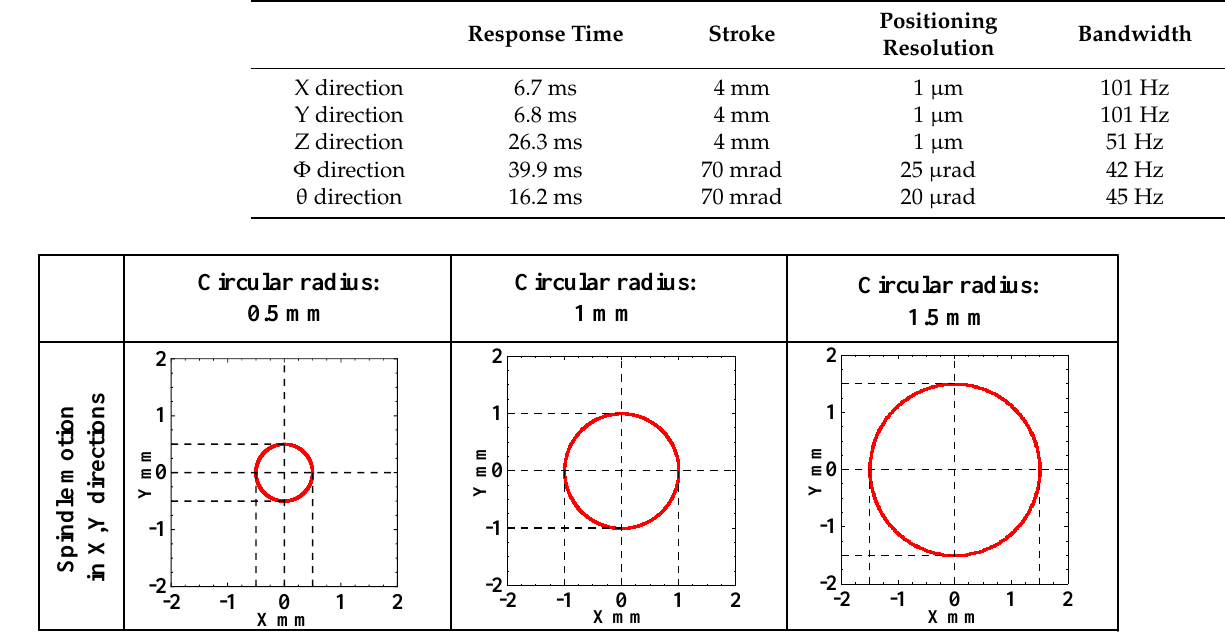
Table 3. Performance evaluation results table.